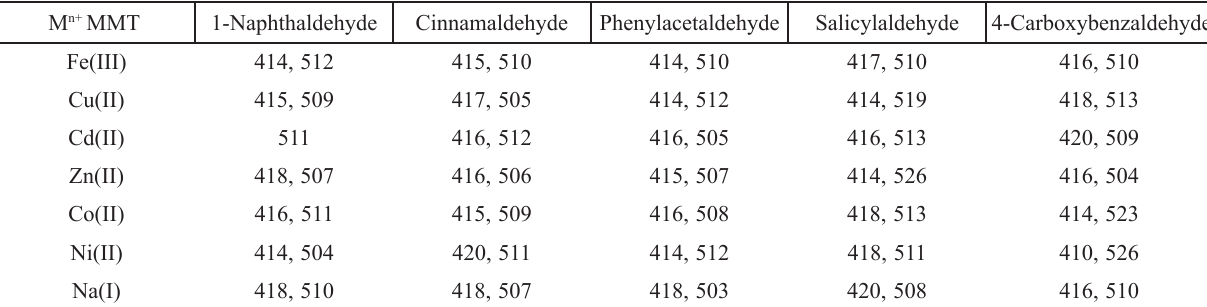
Table 2 – Position of the bands in nm in the visible absorption spectra of the intermediate compounds suspended in chloroform after less than 5 minutes M n+ MMT